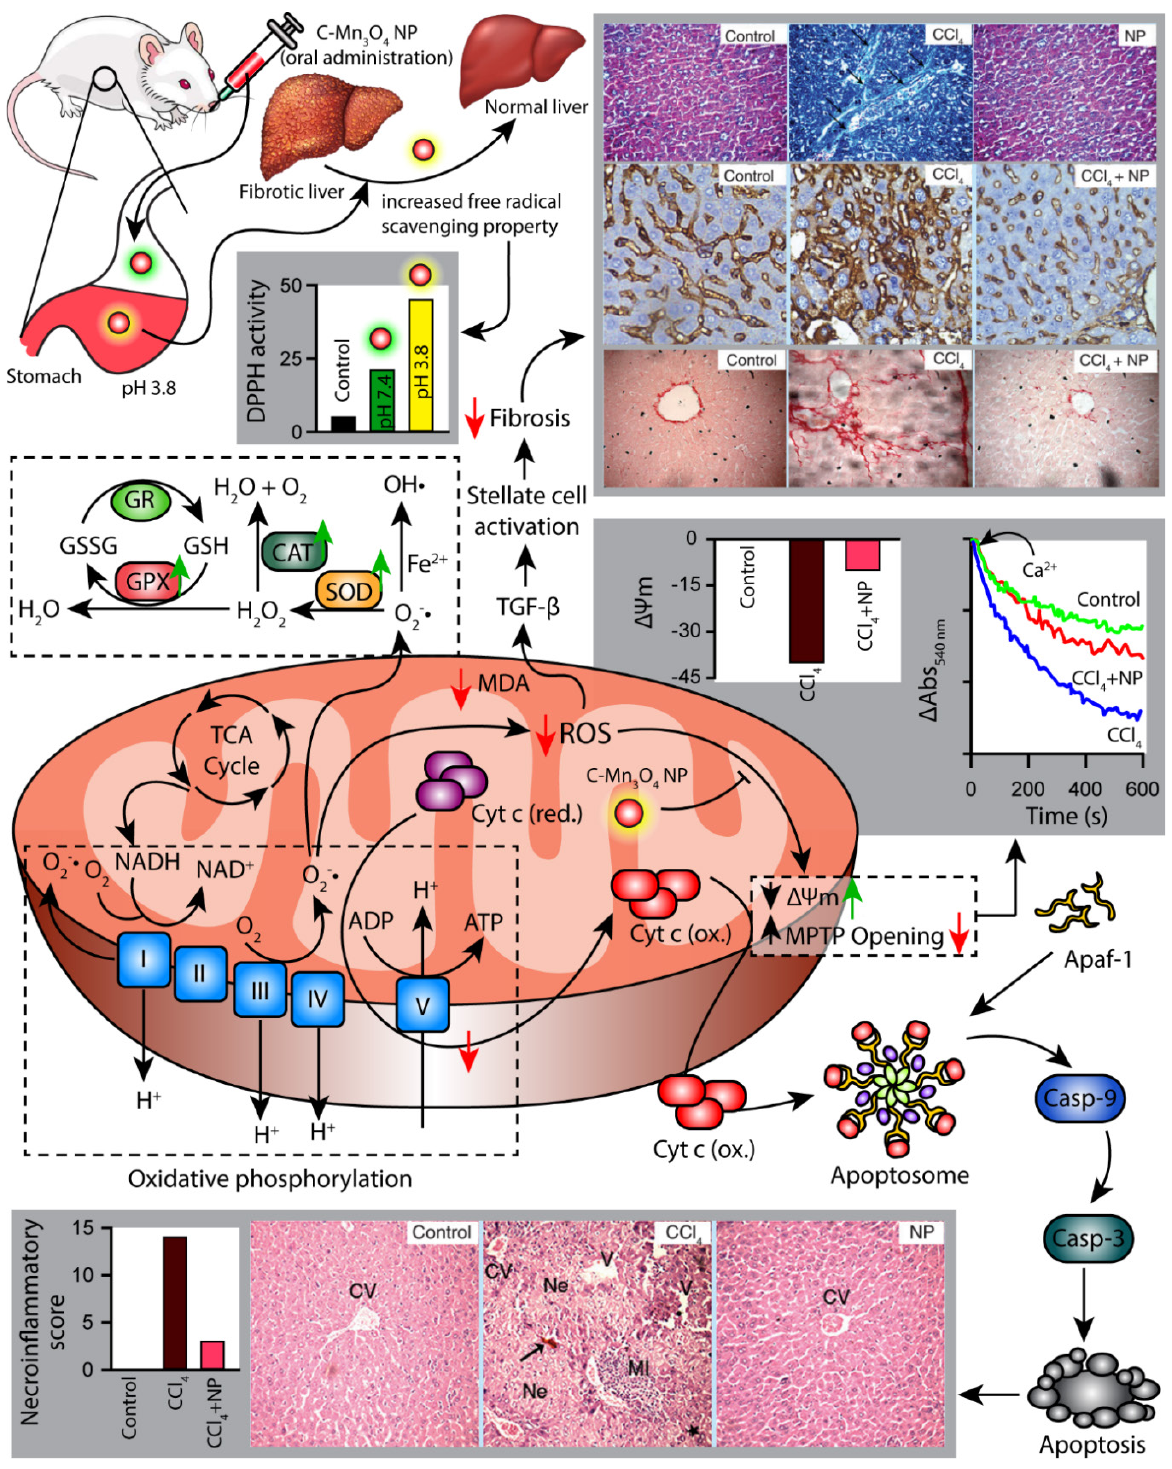
Figure 7: Mitochondrial redox modulation ability of C-Mn O NPs and their application in treatment of hepatic fibrosis. Citrate 3 4 functionalized Mn O nanoparticles can protect mitochondria from oxidative damage through maintaining normal mitochondrial membrane 3 4 potential, MPTP, and decreasing cytochrome c release into the cytosol, in turn blocks apoptosis. On the other hand, a decrease in ROS levels downregulates the process of hepatic stellate cell activation through TGF-β, in turn decreases fibrotic damages as observed by Mason’s trichrome, Sirius red and α-SMA